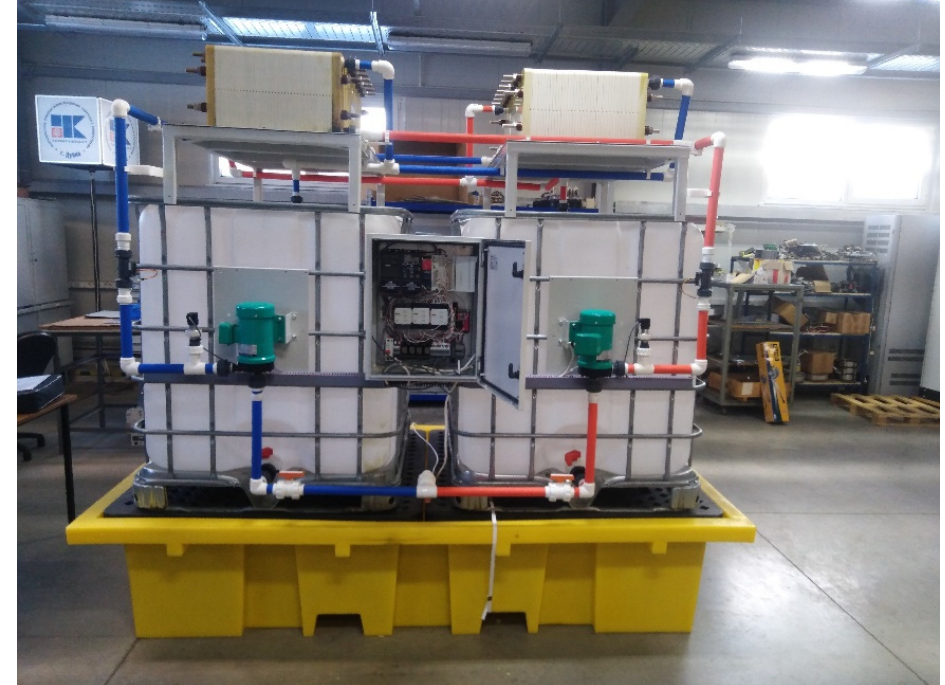
Figure 8. Prototype of the UPS system based on 5 kW/15 kWh VRFB.